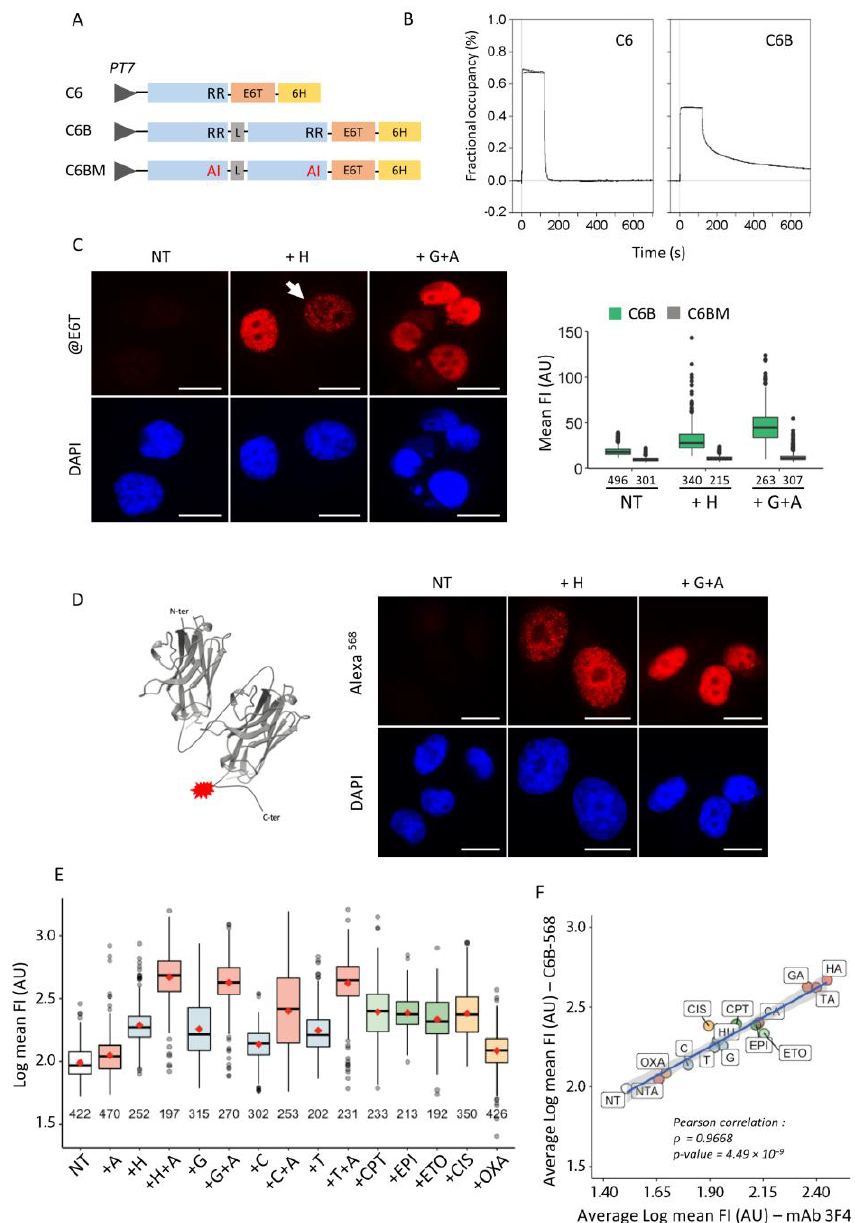
Figure 4. Binding performance of the bivalent C6 nanobody. ( A ) Schematic representation of the constructs used to produce bivalent nanobodies in E. coli cells. The four R residues of bivalent C6 nanobody (C6B) that have been altered to generate the mutant bivalent C6 nanobody (C6BM) are indicated. ( B ) Analysis by SPR of the interaction of monovalent (C6; 180 nM) or bivalent (C6B; 80 nM) C6 nanobody with the phosphopeptide immobilized on chip. The curves show typical normalized profiles of the fractional occupancy calculated with the signals recorded for each nanobody (Materials and Methods). Injection of nanobody was stopped at the 120 s time-point and dissociation was